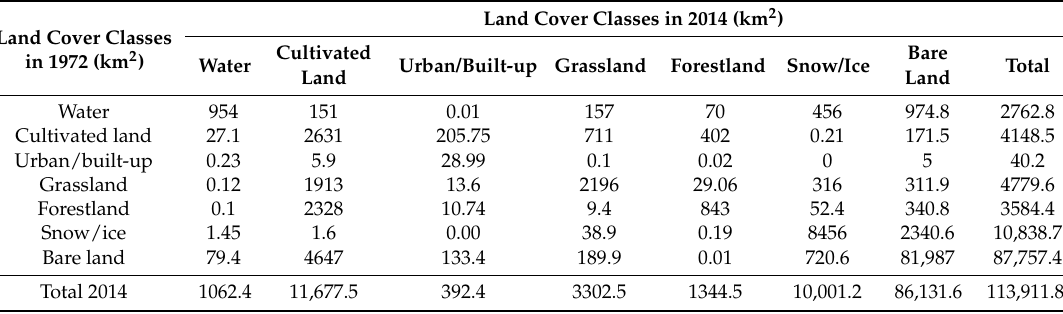
Figure 6. Monthly precipitation variation of mountain region in 2000 and 2014. Table 5. Area transition matrix of Kashgar Region during 1972 to 2014.